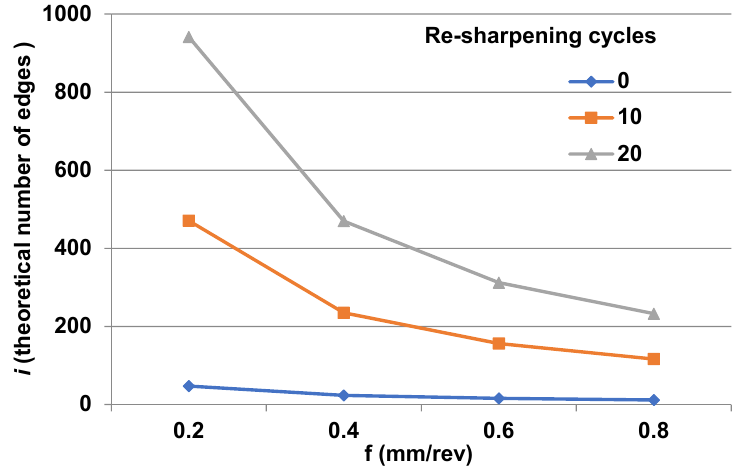
Figure 18. Influence of feed rate on edges using the δ = 2 α strategy for application of r ε = 1.5 mm